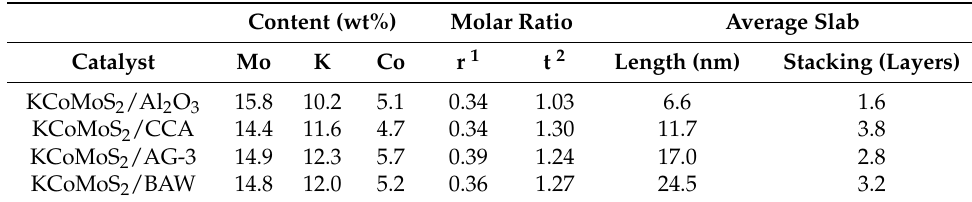
Table 1. Composition of prepared catalysts (XRF) and average slab length and degree of stacking (TEM).